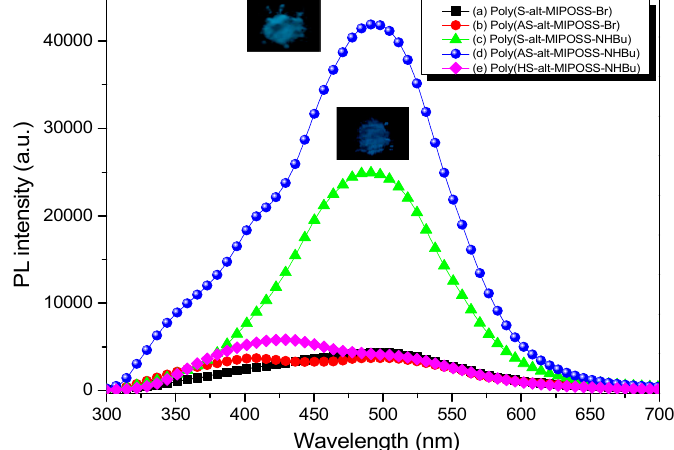
Figure 10. PL spectra of: ( a ) poly(S- alt -MIPOSS-Br); ( b ) poly(AS- alt -MIPOSS-Br) MIPOSS; ( c ) poly(S- alt -MIPOSS-NHBu; ( d ) poly(AS- alt -MIPOSS-NHBu); and ( e ) poly(HS- alt -MIPOSS-NHBu), in the solid state (excitation: 330 nm). Top insert figure is photo image for poly(AS- alt -MIPOSS-NHBu) and the bottom insert figure is photo image for poly(S- alt -MIPOSS-NHBu) under excitation at 330 nm.